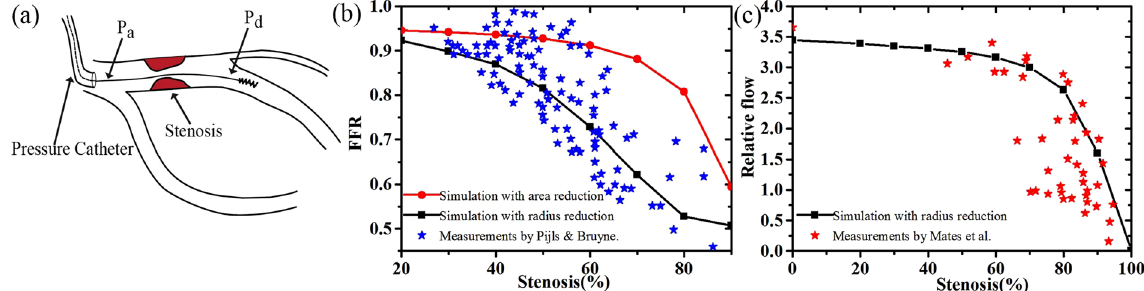
Figure 5. ( a ) A typical display of coronary stenosis and FFR. ( b ) PDA of our simulations versus stenoses, compared with the measurements by Pijls & Bruyne 27 , ( c )non-dimensional flow simulation versus stenosis, compared with the measurements by Mates et al . 28 .